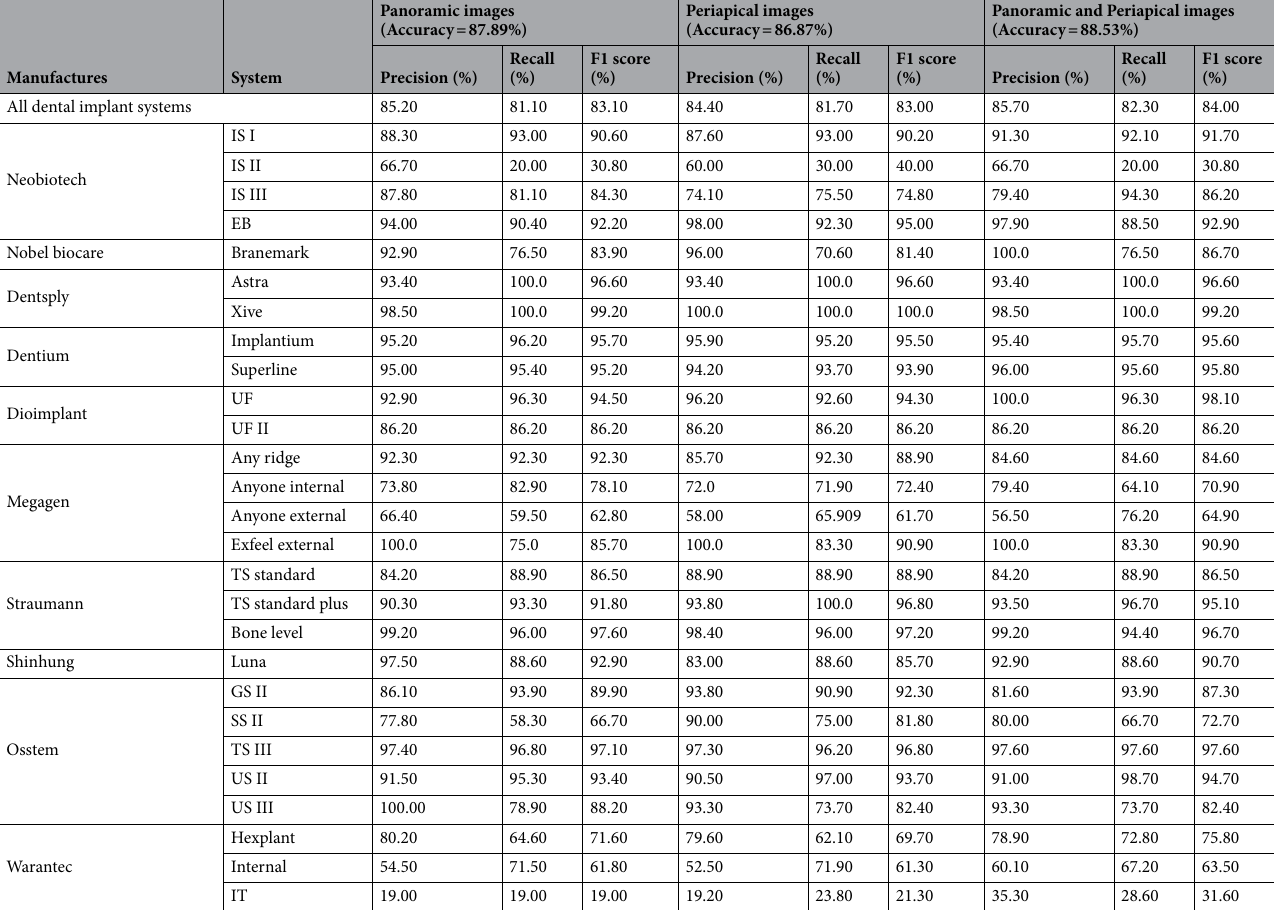
Table 1. Accuracy performance of automated deep learning